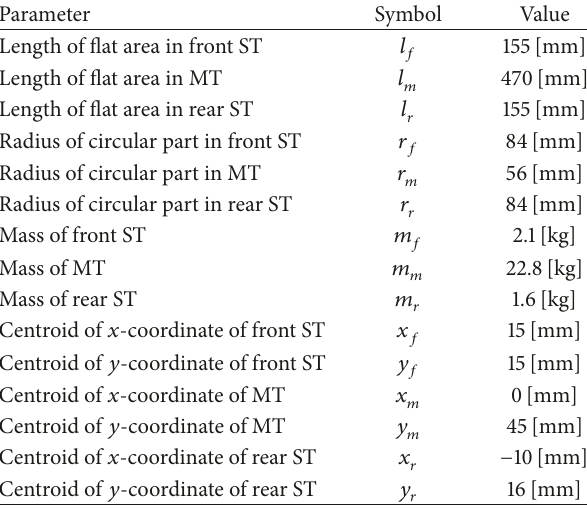
Figure 17: Changeable mockup stairs. Table 1: Specification of the